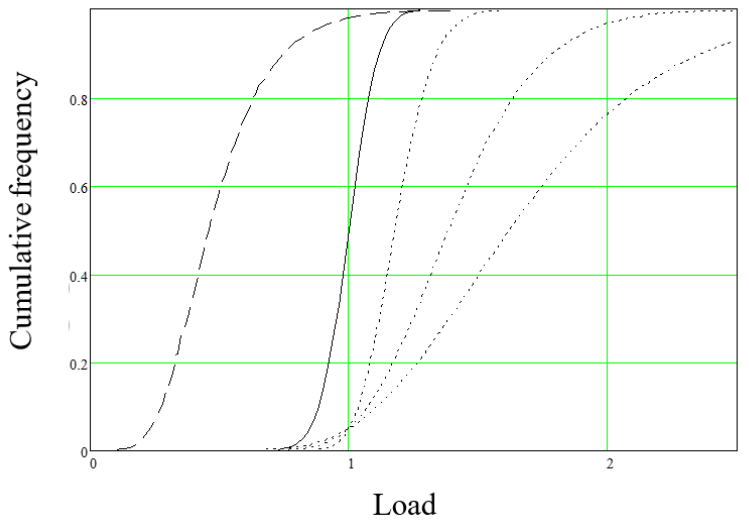
Figure 1. The distributions in the serviceability limit state (SLS). Solid line, permanent load; dashed line, variable load; dotted lines, material property, steel, timber, and concrete.